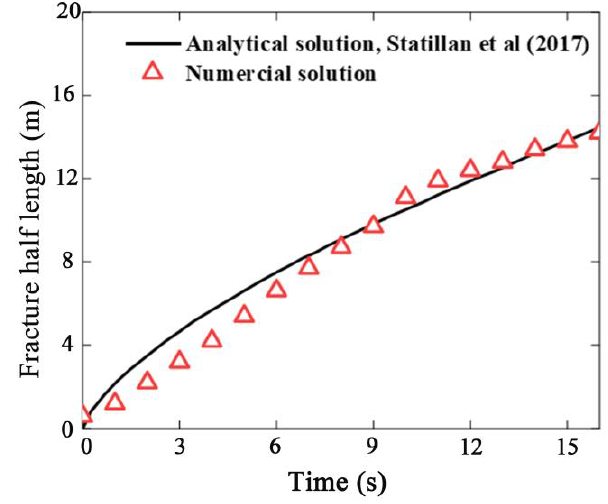
Figure 1. Comparison with the analytical solution [47].